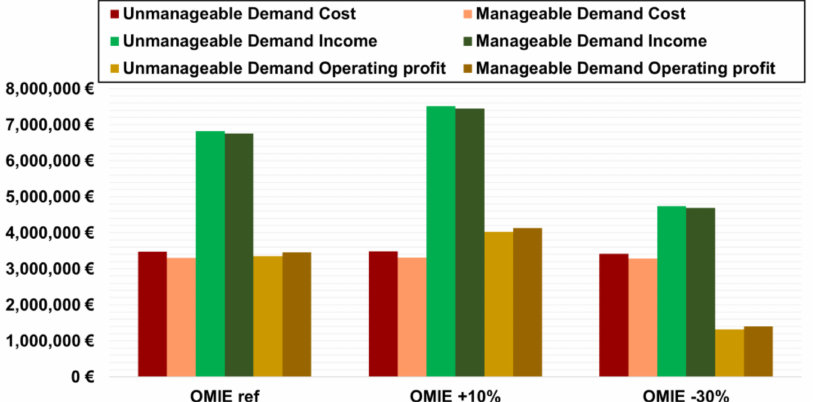
Figure 7. Evolution of annual costs and income of the system with and without intraday demand